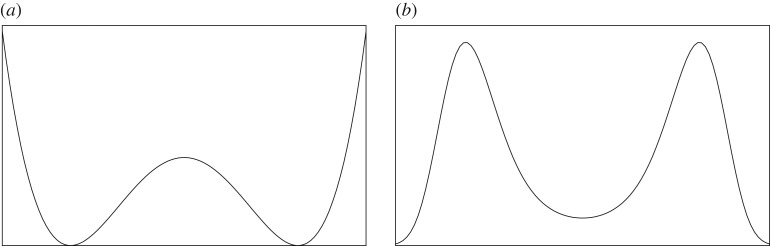
For n = 1, the double-well potential V (a) and single-spin density e−V (b).